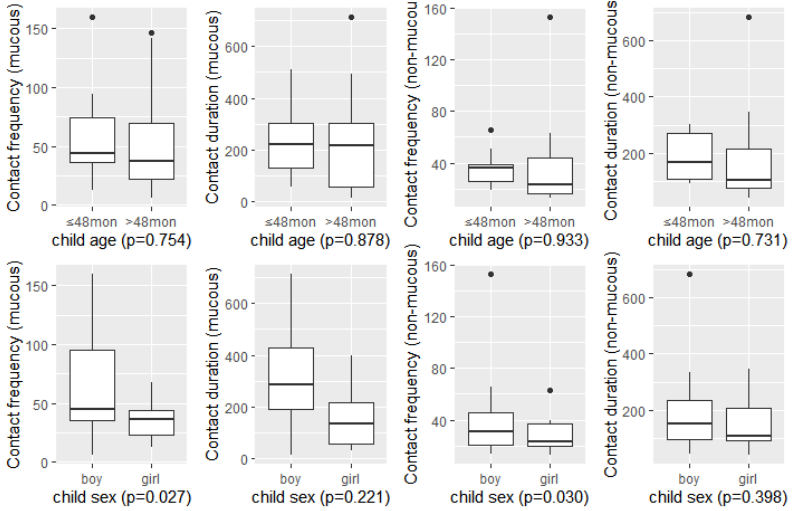
Figure 4. Differences in contact frequency and contact duration by child age and gender. Single variance analysis ( n = 30, 2 h observation time).